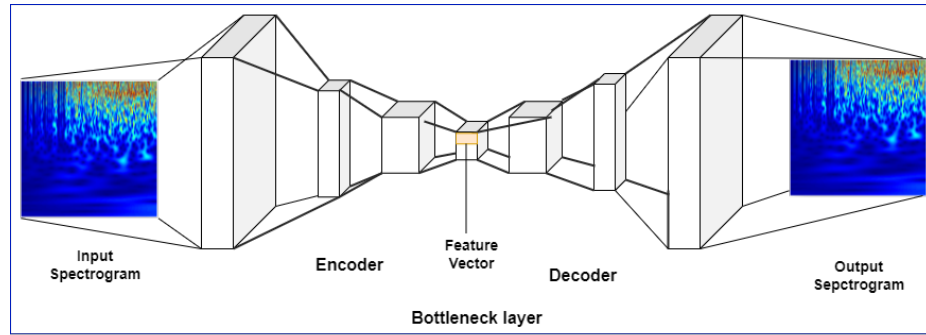
Figure 3. Visualization of the proposed architecture of stacked autoencoder.